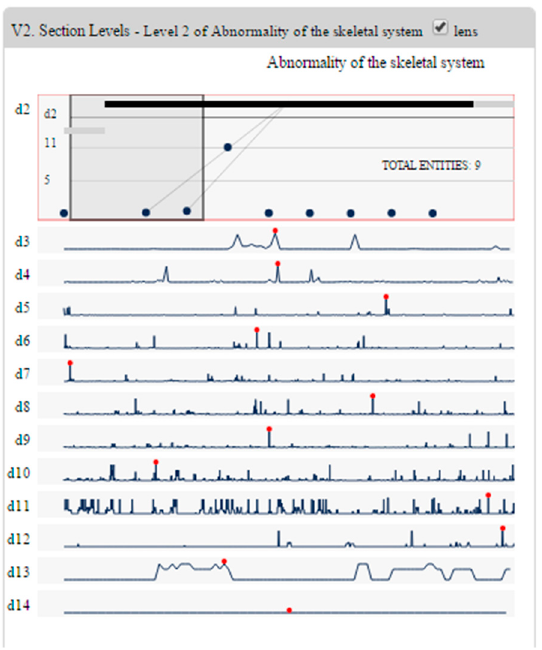
Figure 25. An overview of the Section Levels Panel subview depicting the “Skeletal System” ontology section levels after navigating from the Ontology Sections Panel subview.